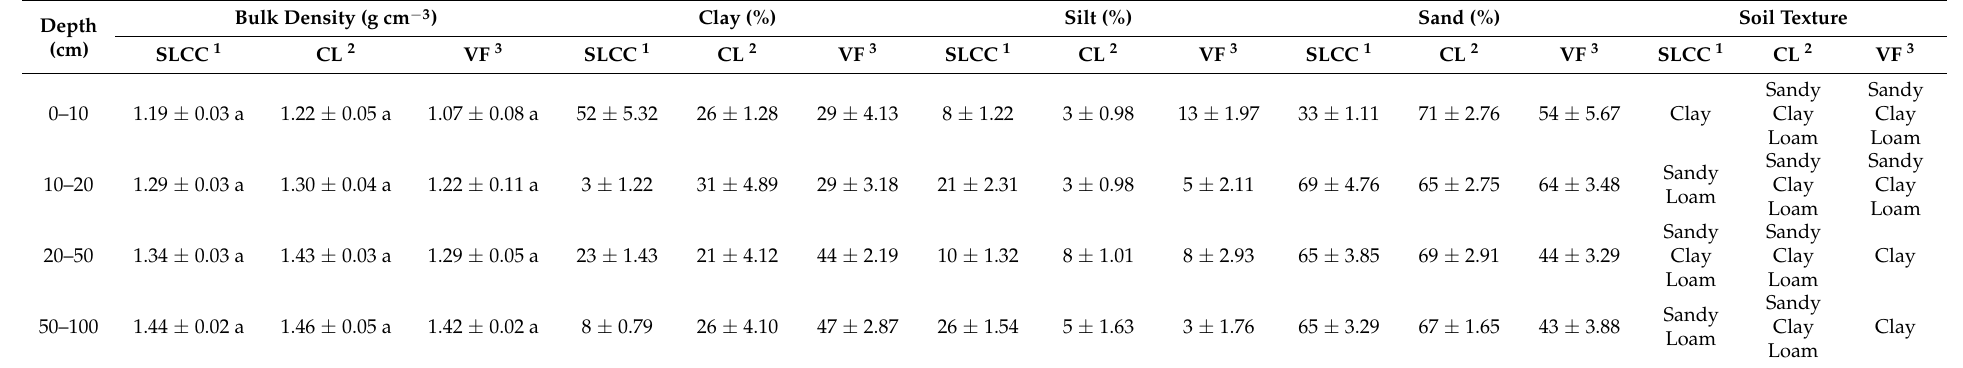
Table 2. Soil physical properties at four depths (0–100 cm) in supervised logging with climber cutting plots (SLCC), conventional logging plots (CL), and virgin forest plots (VF).